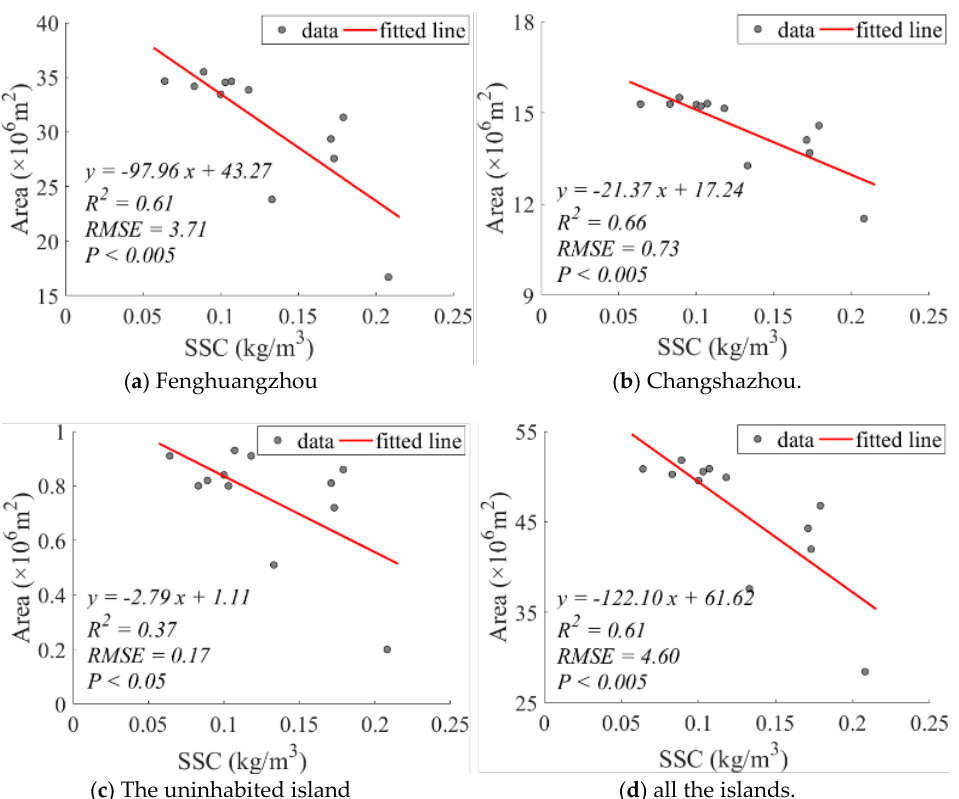
Figure 6. Relationships between monthly area of river islands and the monthly mean SSC of Datong hydrological station .